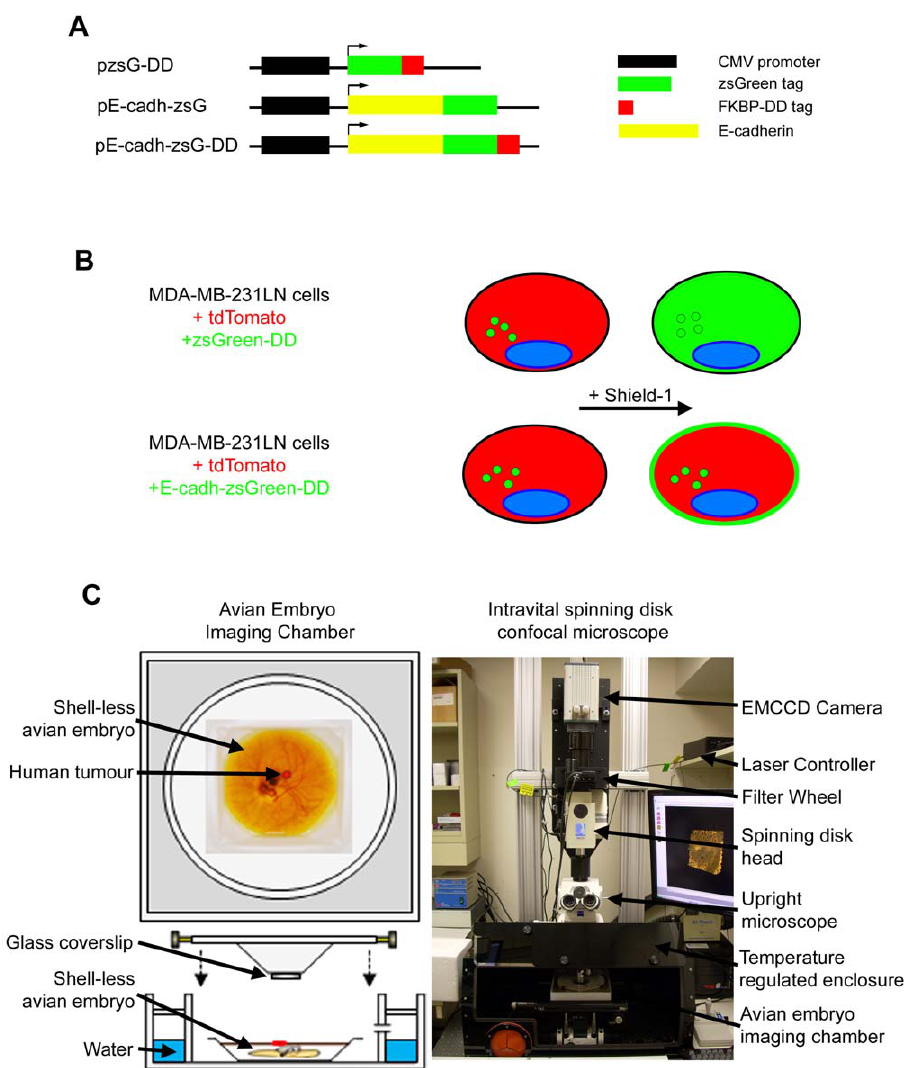
Figure 1. A chemically tunable form of E-cadherin for use in intravital imaging. A) Expression vectors encoding tunable zsGreen (pzsGreen- DD), fluorescent E-cadherin (pE-cadh-zsG) and tunable fluorescent E-cadherin (pE-cadh-zsG-DD). Components include CMV promoter (pCMV), zsGreen fluorescent protein (zsGreen), the Shield-1 binding degradation domain (FKBP-DD), and E-cadherin. B) Schematic of MDA-MB-231-luc- D3H2LN (231LN) cells used to express tunable proteins and the predicted behavior of cells in the presence or absence of Shield-1. 231LN tumor cells were stably transfected with tdTomato and zsGreen alone or as a fusion with E-cadherin. C) Intravital imaging platform (right) with avian embryo imaging chamber (left) to maintain proper temperature (37 u C) and humidity ( . 90%) used to perform in vivo three dimensional time-lapse imaging of micrometastases in the chorioallantoic membrane of the avian embryo. doi:10.1371/journal.pone.0030177.g001 luc-D3H2LN human breast carcinoma cell line by chemically modulating intracellular levels of E-cadherin (E-cadh). E-cadherin is